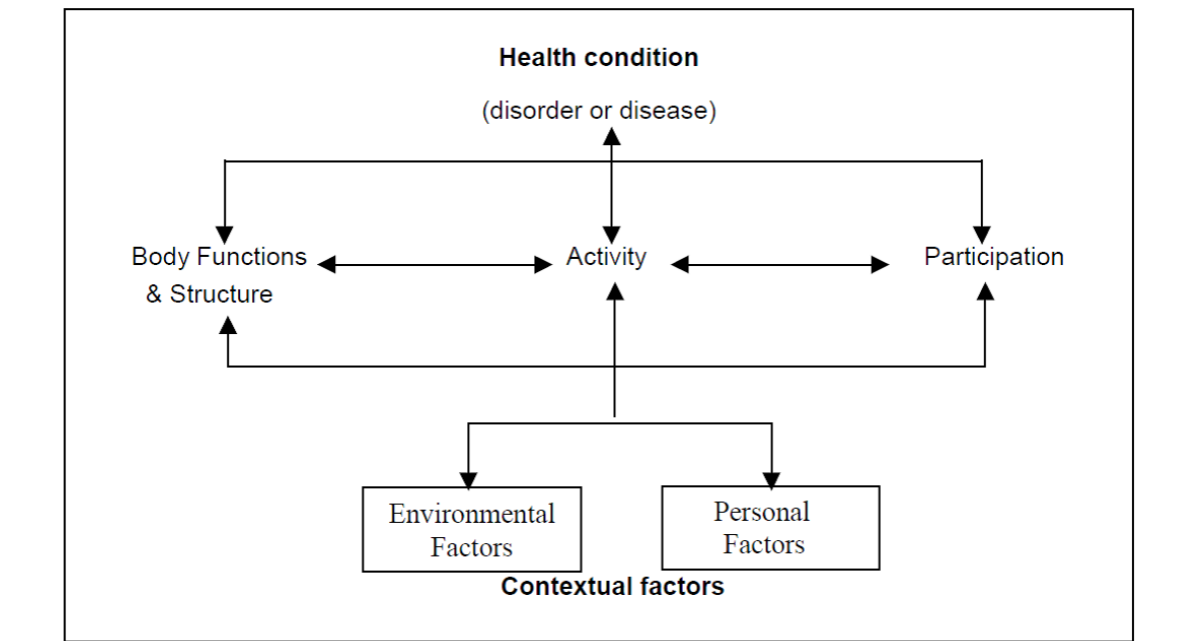
Figure 1. Model of disability that is the basis of International Classification of Functioning, Disability and Health